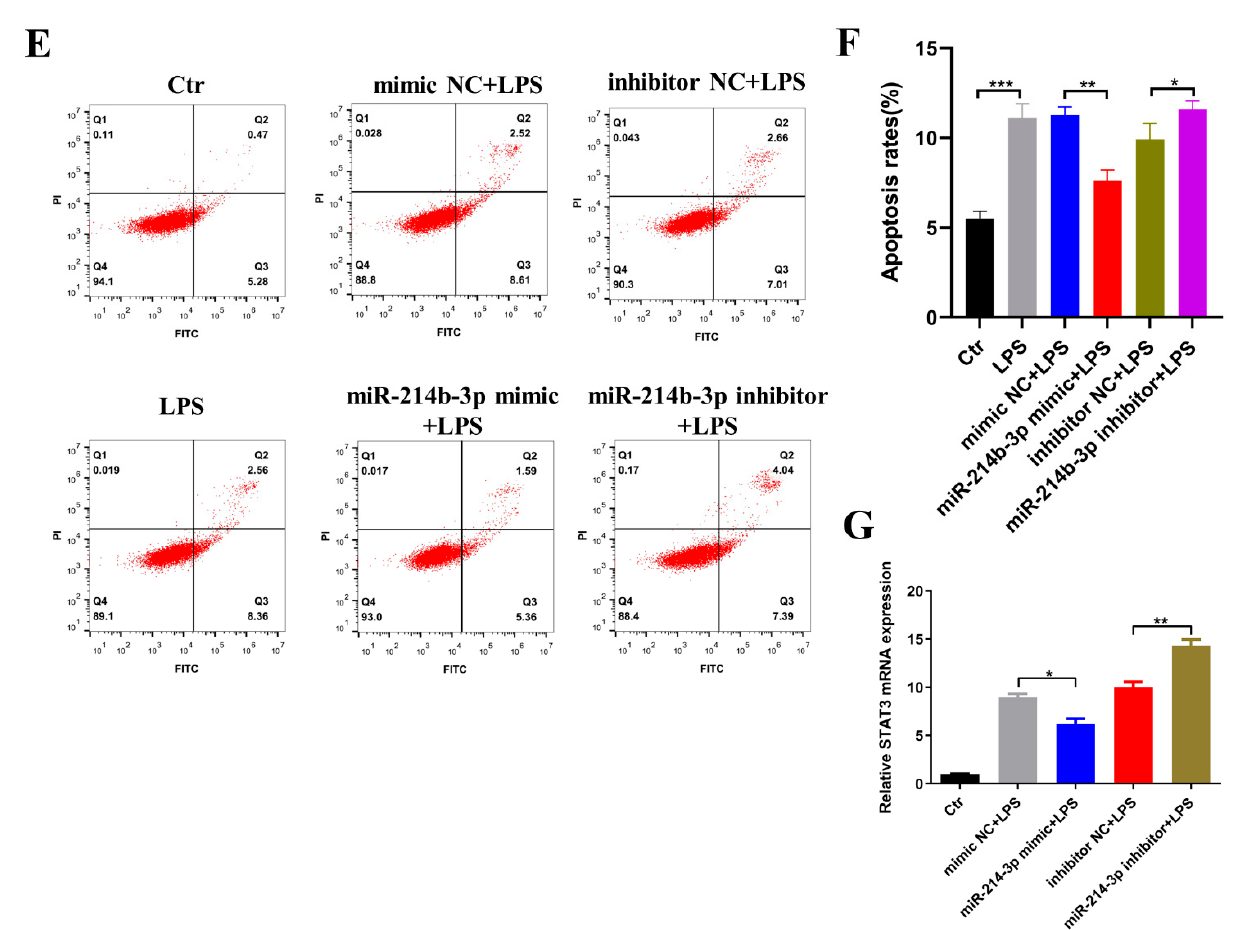
Figure 4. miR-214b-3p alleviated LPS-induced inflammation and apoptosis in HD11 cells: ( A , B ) The expression levels of miR-214b-3p were reduced in coccidia-infected samples and the LPS-induced HD11 inflammatory model, as detected by qRT-PCR. ( C , D ) The expression levels of IL-6, TNF- α , and IFN- γ in LPS-stimulated HD11 cells with miR-214b-3p mimics and inhibitors, as detected by qRT-PCR and ELISA. ( E , F ) Cell apoptosis was detected with Annexin V–FITC/PI double-staining via flow cytometry assay. ( G ) The mRNA levels of STAT3 in HD11 cells with miR-214b-3p mimics and inhibitors. Data are presented as means ± SD ( n = 3 biologically independent samples). * p < 0.05; ** p < 0.01; *** p < 0.001 (Student’s t